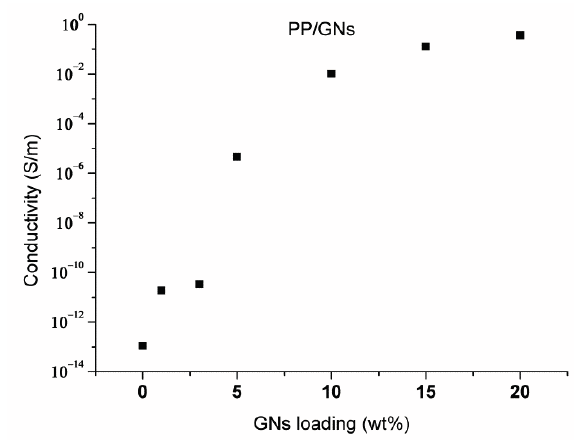
Figure 8. Conductivity of PP/ GNs composites as related to various blending ratios.